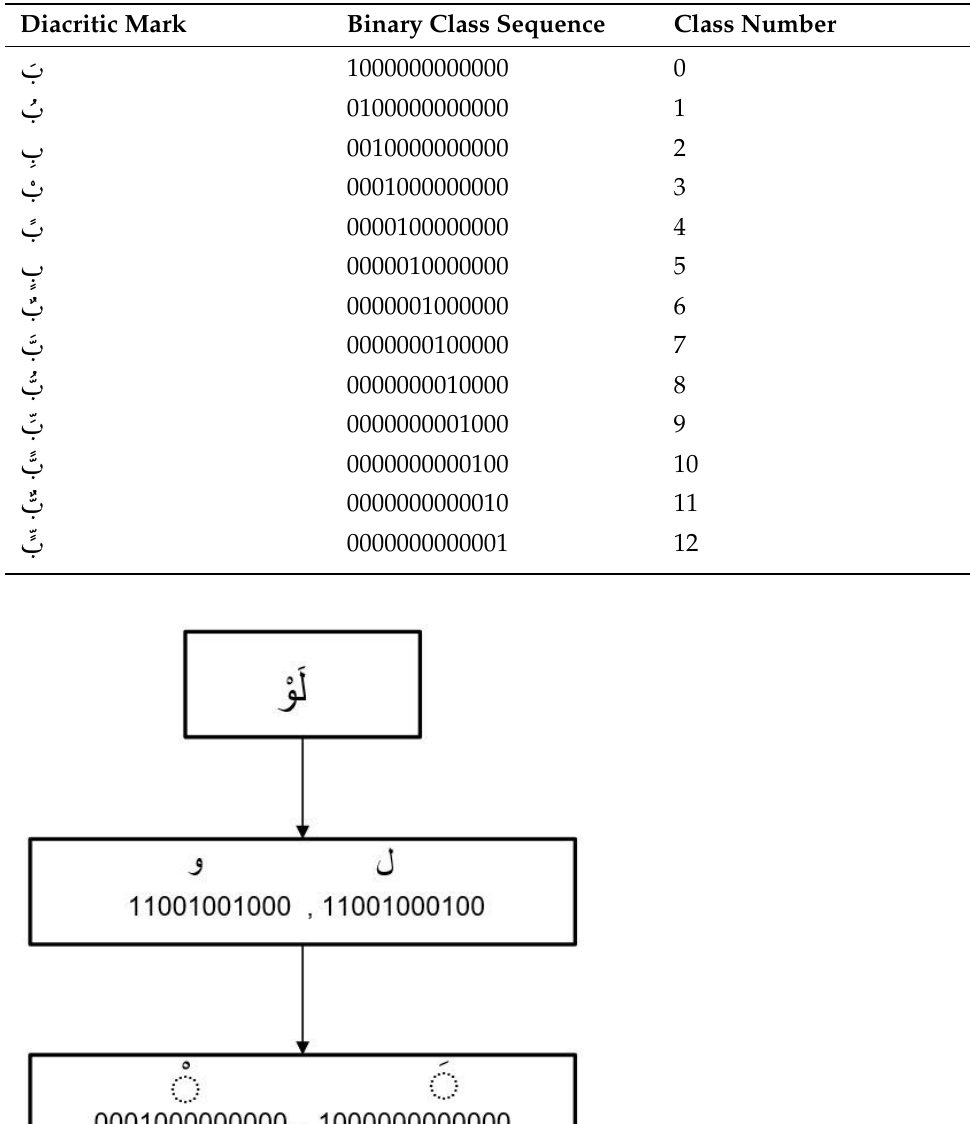
Table 3. Diacritics marks class sequences.